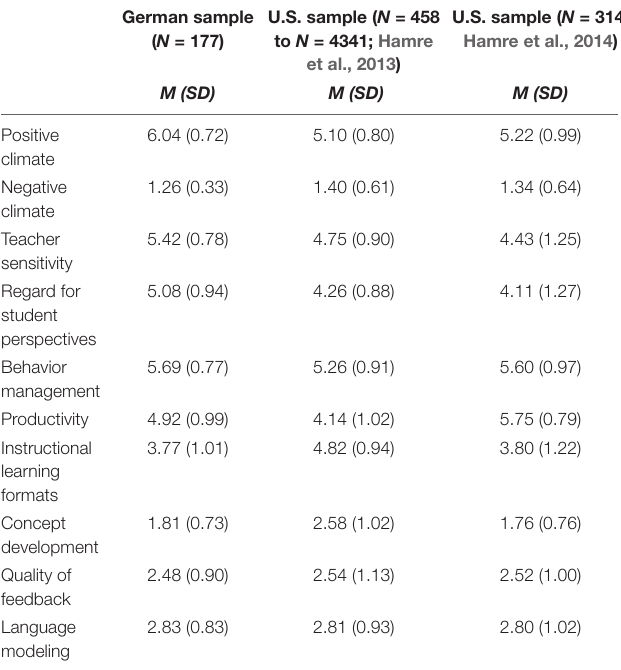
TABLE 1 | Descriptives of our sample, and comparison with American